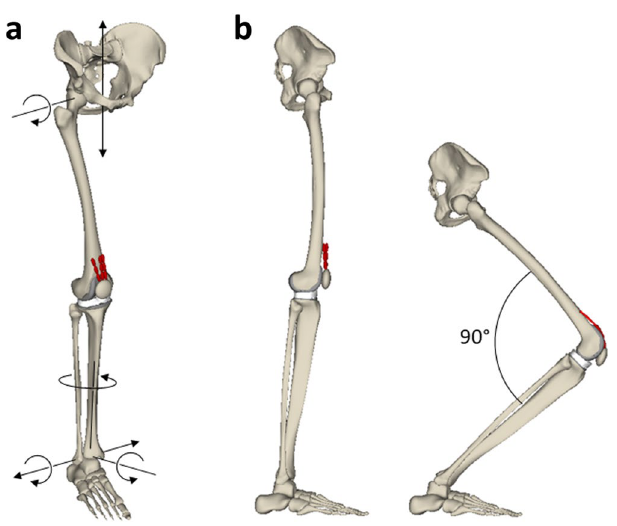
Figure 3. ( a ) Multibody model of the lower right limb with black arrows indicating the DOF assigned to the pelvis, hip, and ankle during the squat simulation; ( b ) lateral view of the model in extension and 90°